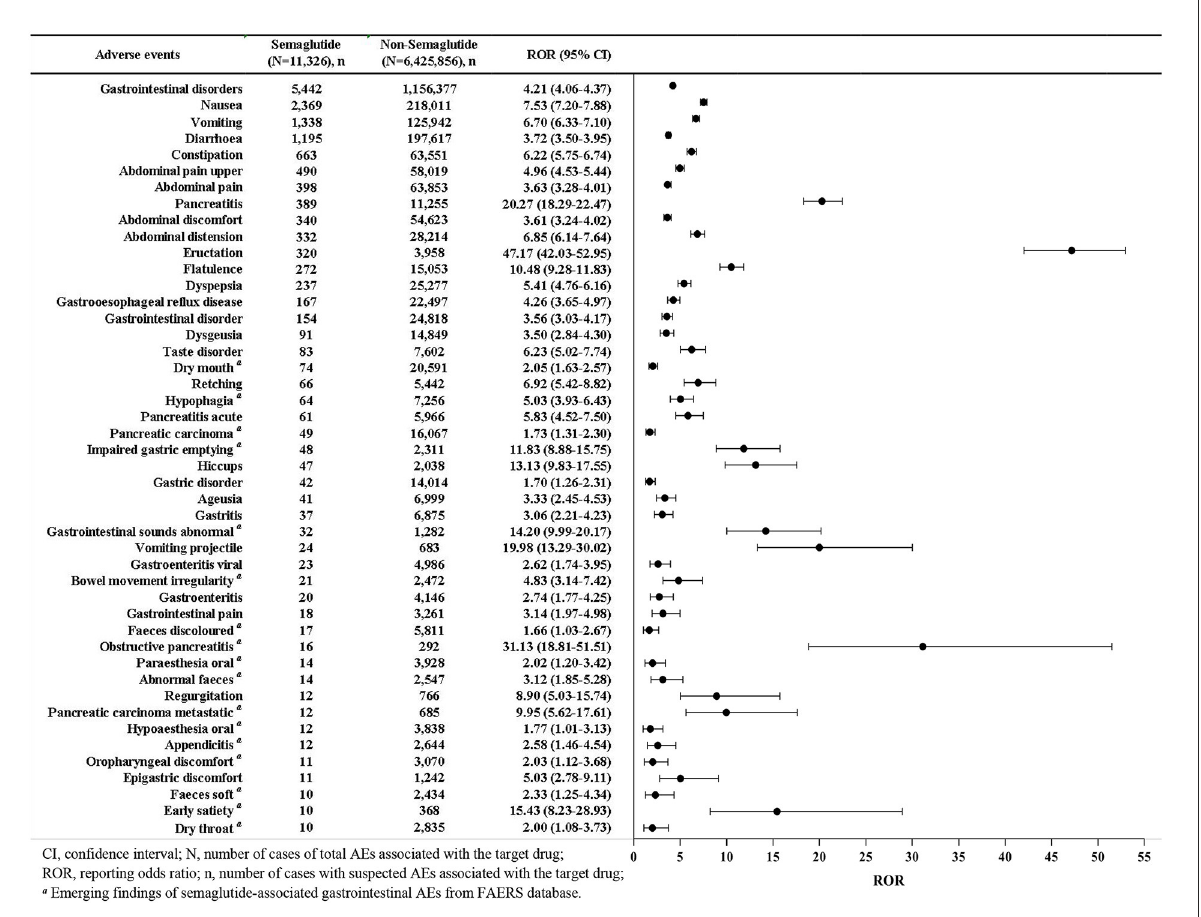
FIGURE2 Reporting odds ratios (ROR) with 95% CI for all positive semaglutide-related gastrointestinal AEs.